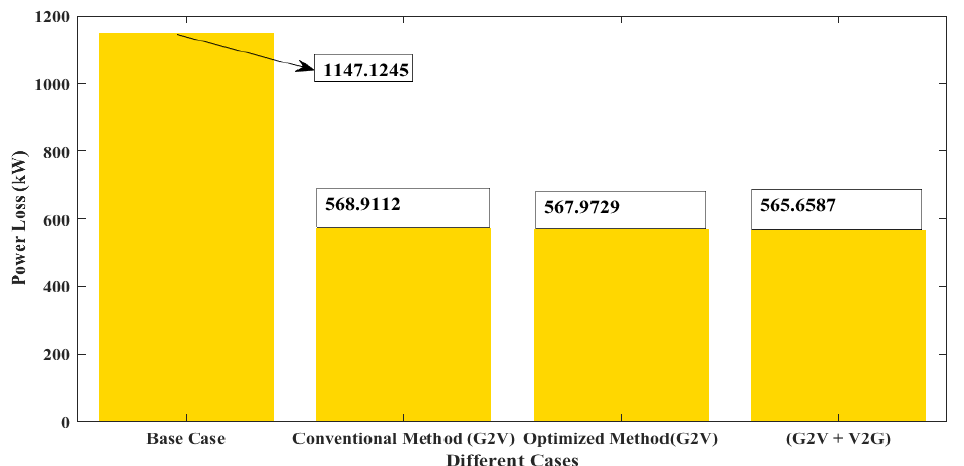
Figure 22. Compared P Loss with conventional, optimized EV charging method and G2V + V2G.